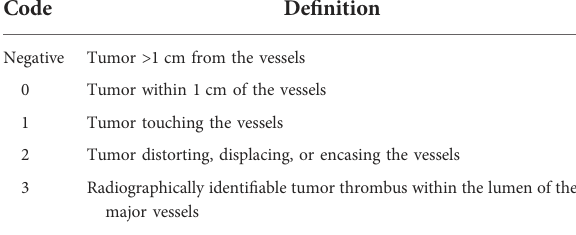
TABLE 1 Grading the proximity of the tumor to the major liver